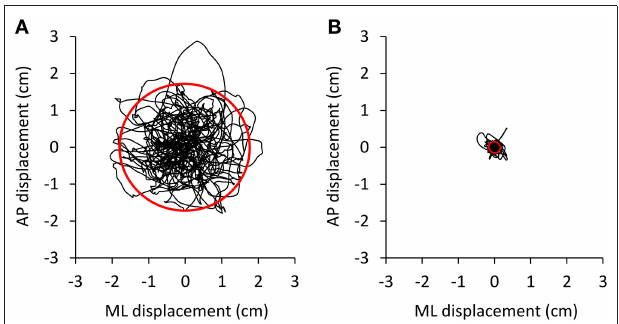
FIGURE 3 | Effect of high-pass filtering. Body oscillations during a 90s trial were performed with EC on the foam base of support by a representative subject. The oscillations normally ranged about 3–4cm in both mediolateral (ML) and anteroposterior (AP) directions (A) . (B) The shrink of the oscillation pattern of the same trial as in A when the AP and ML time series were computed on the 2Hz high-pass filtered signals.